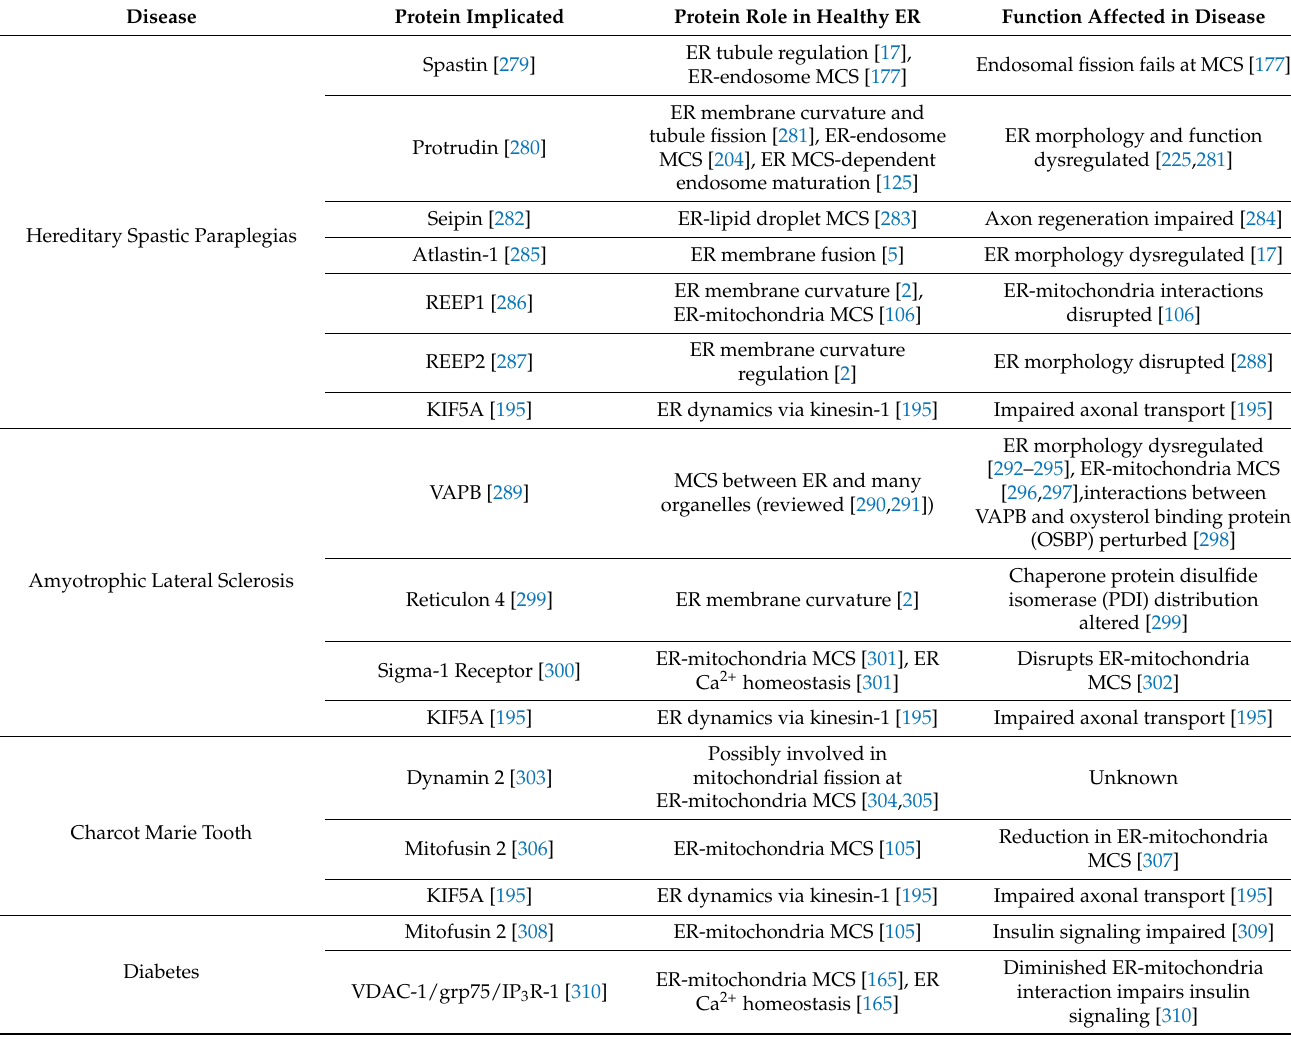
Table 1. Diseases related to ER morphology and dynamics. The proteins mutated in the disease or related to the replication of the pathogen are listed, alongside their normal functions in the ER and how their function is affected/hijacked in the